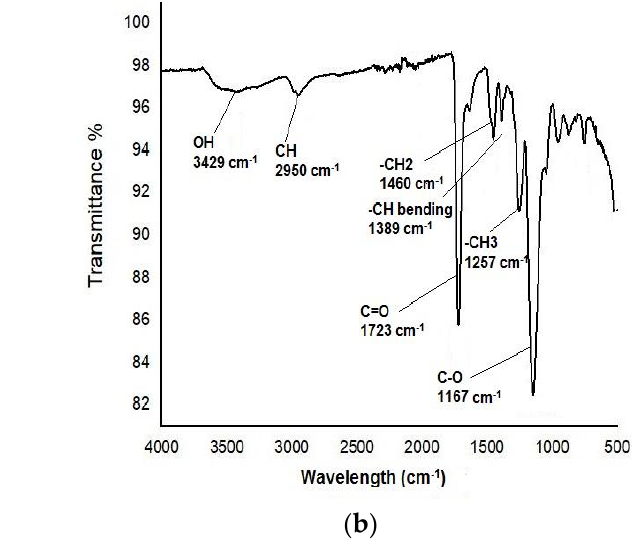
Figure 3. FTIR spectra of the MIP ( a ) and NIP ( b ).